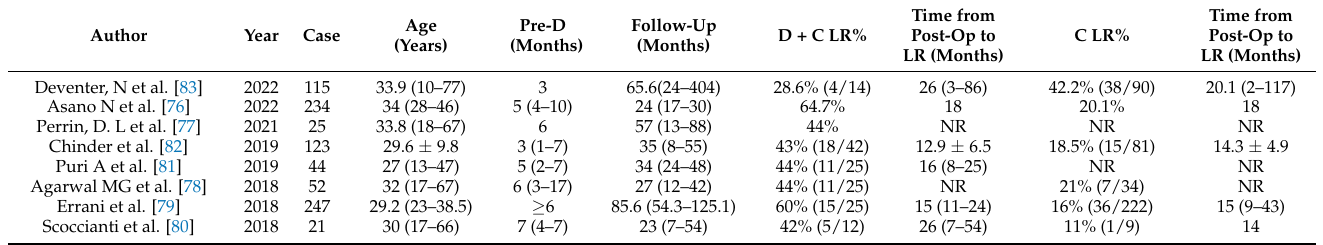
Table 2. Summary of preoperative denosumab combined with curettage in the treatment of operable